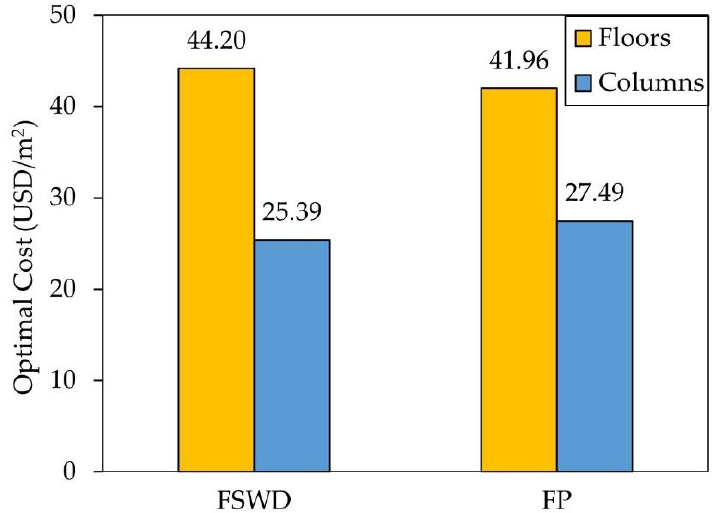
Figure 16. Distribution of structural elements costs for the best design alternatives.